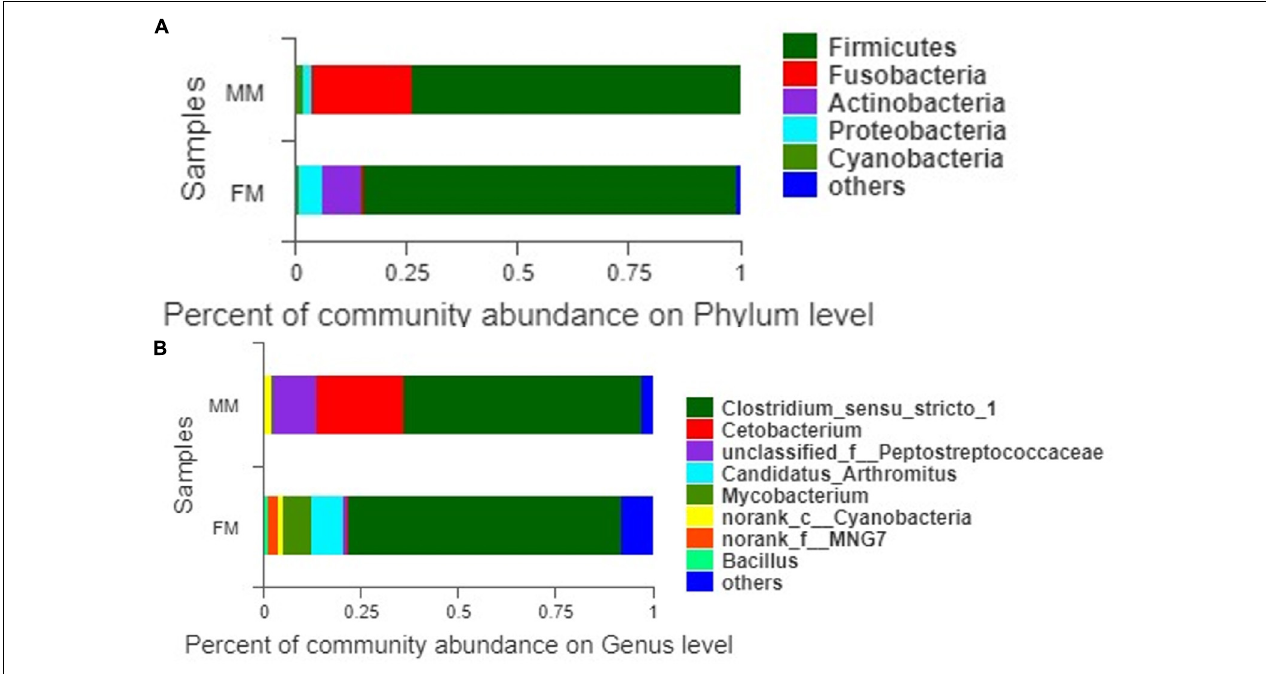
FIGURE 2 | The intestinal bacterial communities at the phylum level (A) and the genus level (B) .